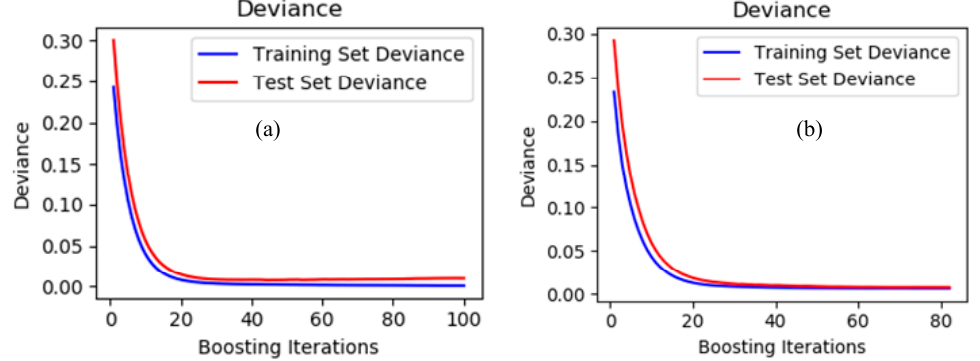
Figure 7. Comparison of training and Test performance between ( a ) before optimization and ( b ) after optimization of the gradient boosting regression tree (GBRT) algorithm.